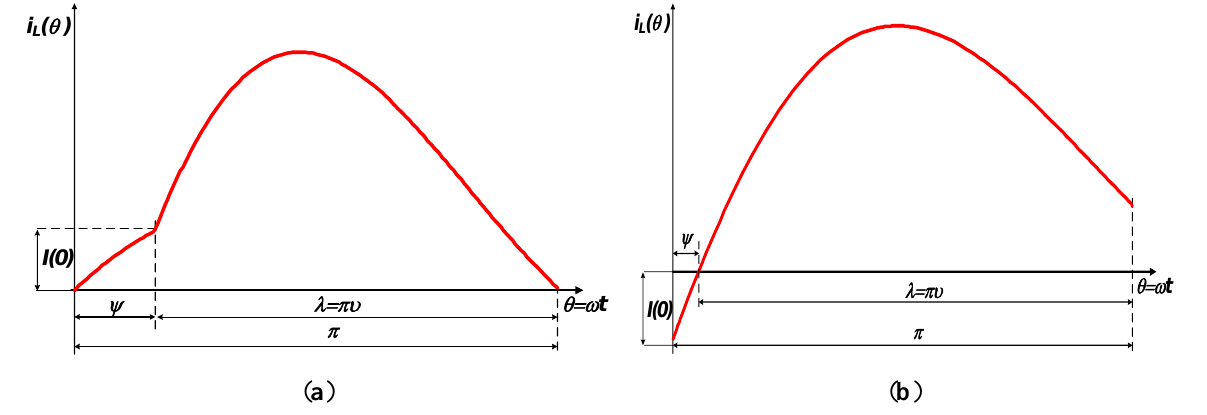
Figure 3. Steady State Inductance Current Shape of a Resonant DC/AC Converter with Reverse Diodes: ( a ) with a control frequency below resonance; ( b ) with a control frequency above resonance.